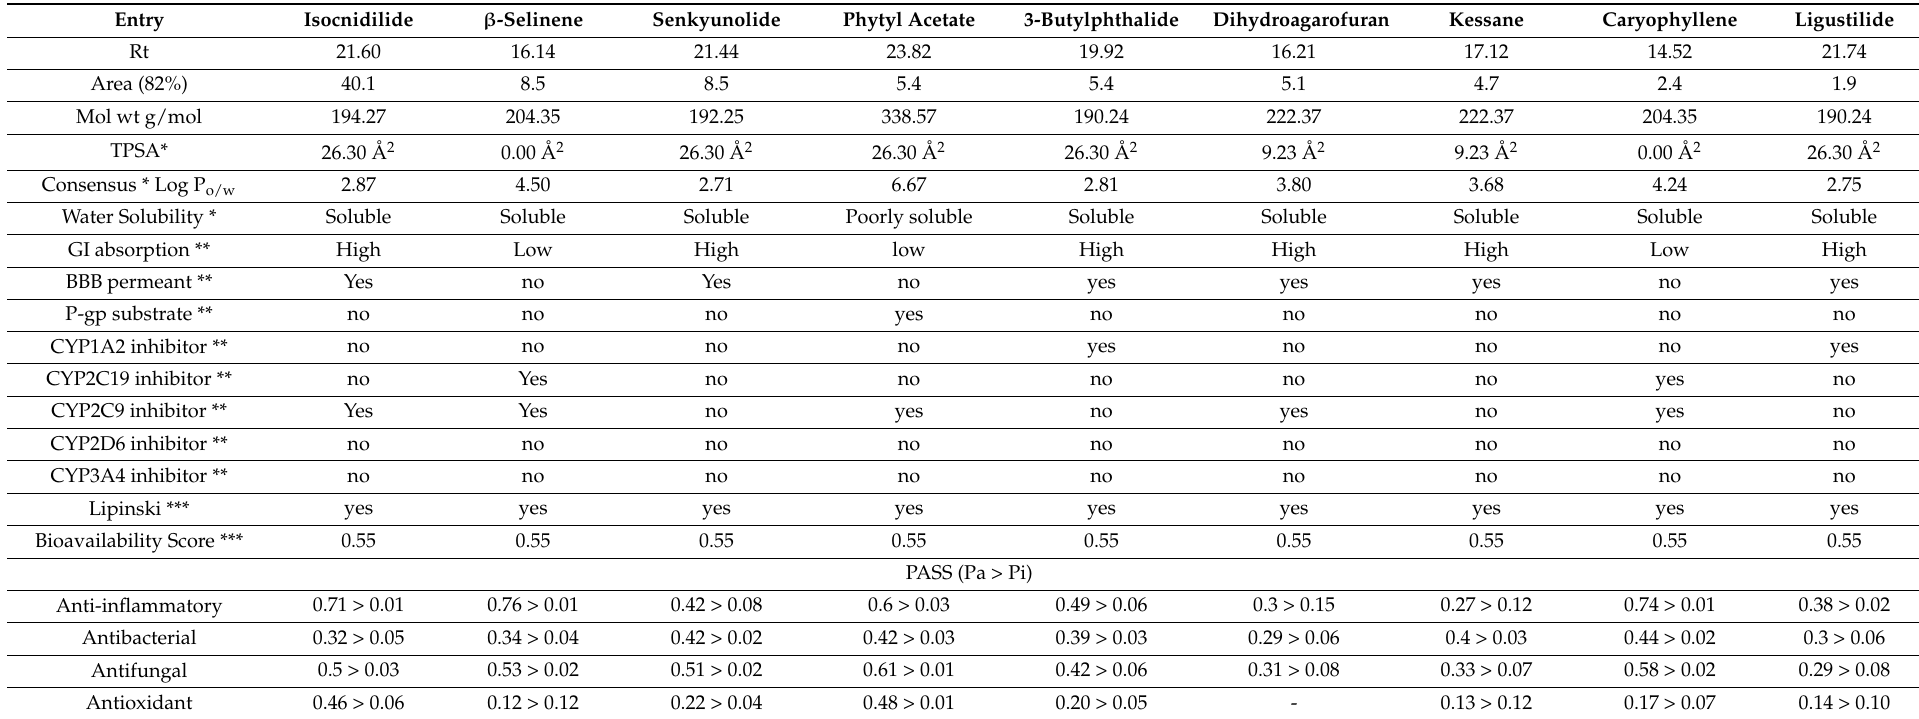
Table 3. In silico ADMET profile of AGO